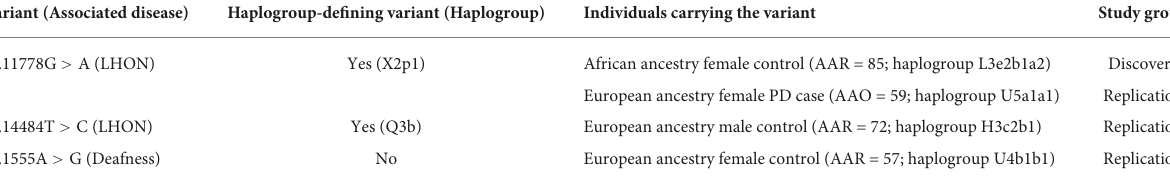
TABLE 1 Study participants carrying mitochondrial DNA variants previously confirmed to be associated with a